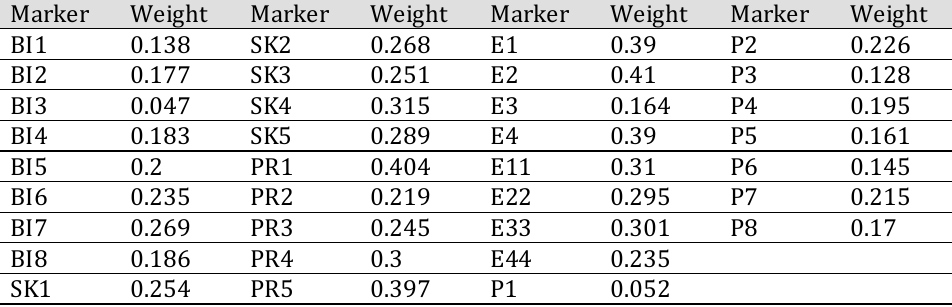
Table 4. External weights values for the markers of each